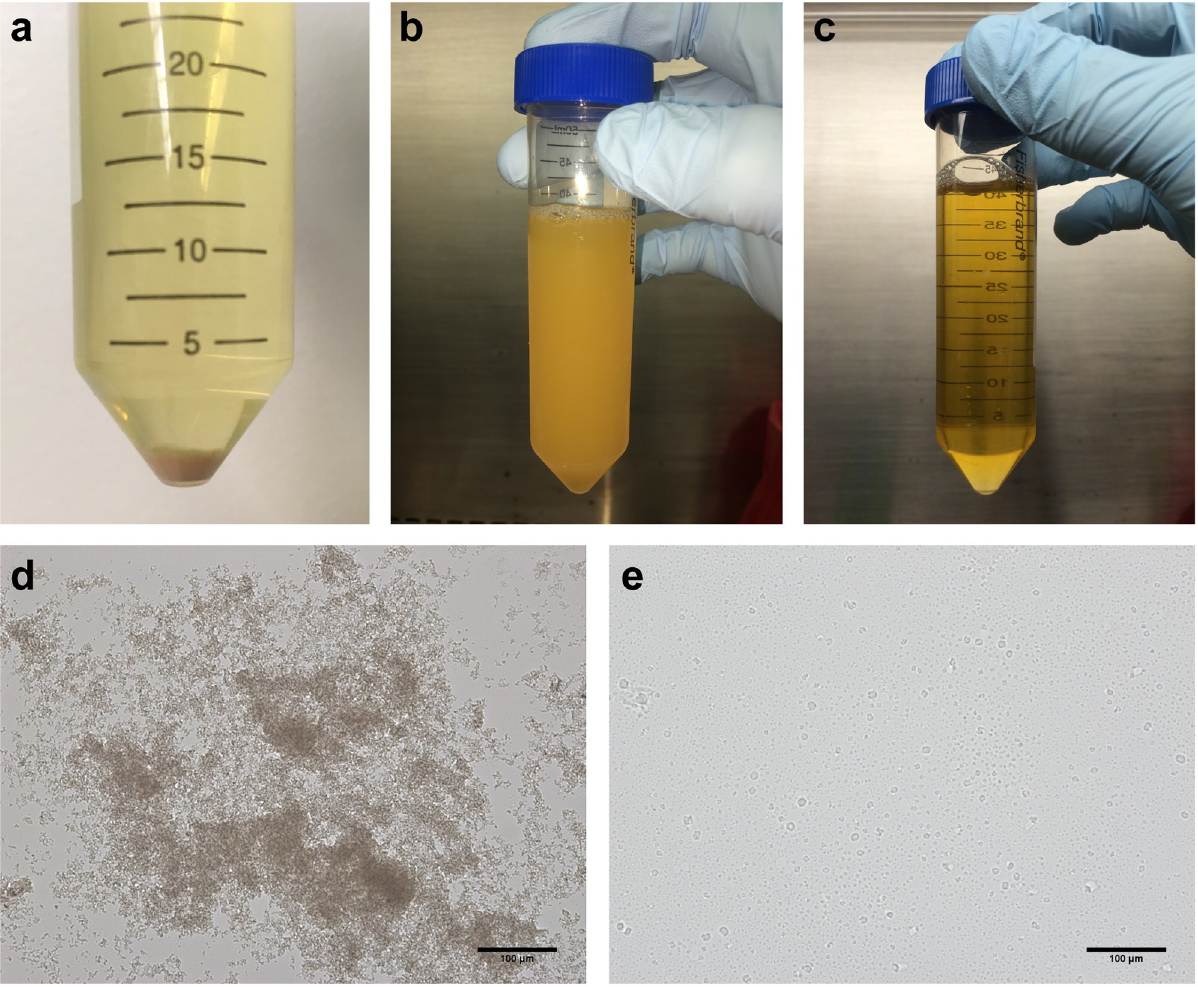
Fig 1. Images and microscopy of urine crystal precipitation and dissolution. (a) Pellet from refrigerated urine sample with crystal precipitation. After centrifugation, pellet is pink in appearance. (b) Refrigerated urine sample with crystal precipitation before and (c) three minutes after Tris-EDTA addition. (d) Microscopic view (20X) of crystals from urine pellet without and (e) with Tris-EDTA addition.